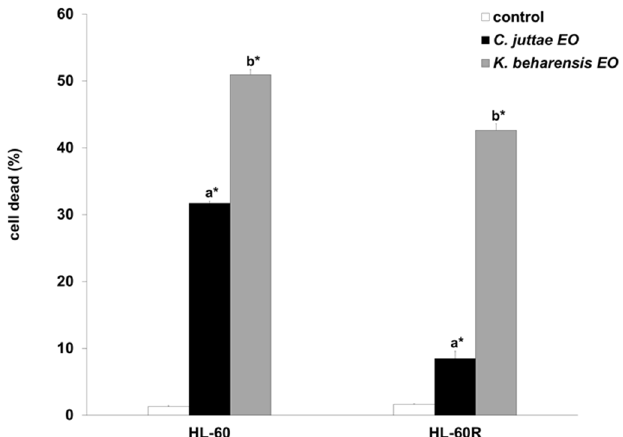
Figure 5. Induction of cell death by C. juttae or K. beharensis oils in HL-60 and HL-60 R cells.